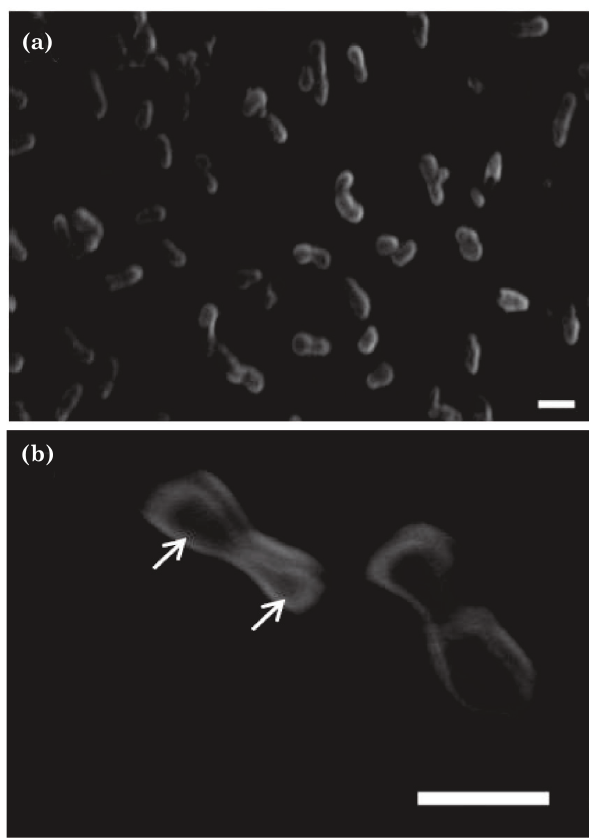
Figura 2. Eletromicrografias mostrando a forma celular típica encontrada para os isolados dos tipos 2 e 3. Setas em (b) mostram os glóbulos lipídicos nos polos do bastonete. As barras equivalem a 2